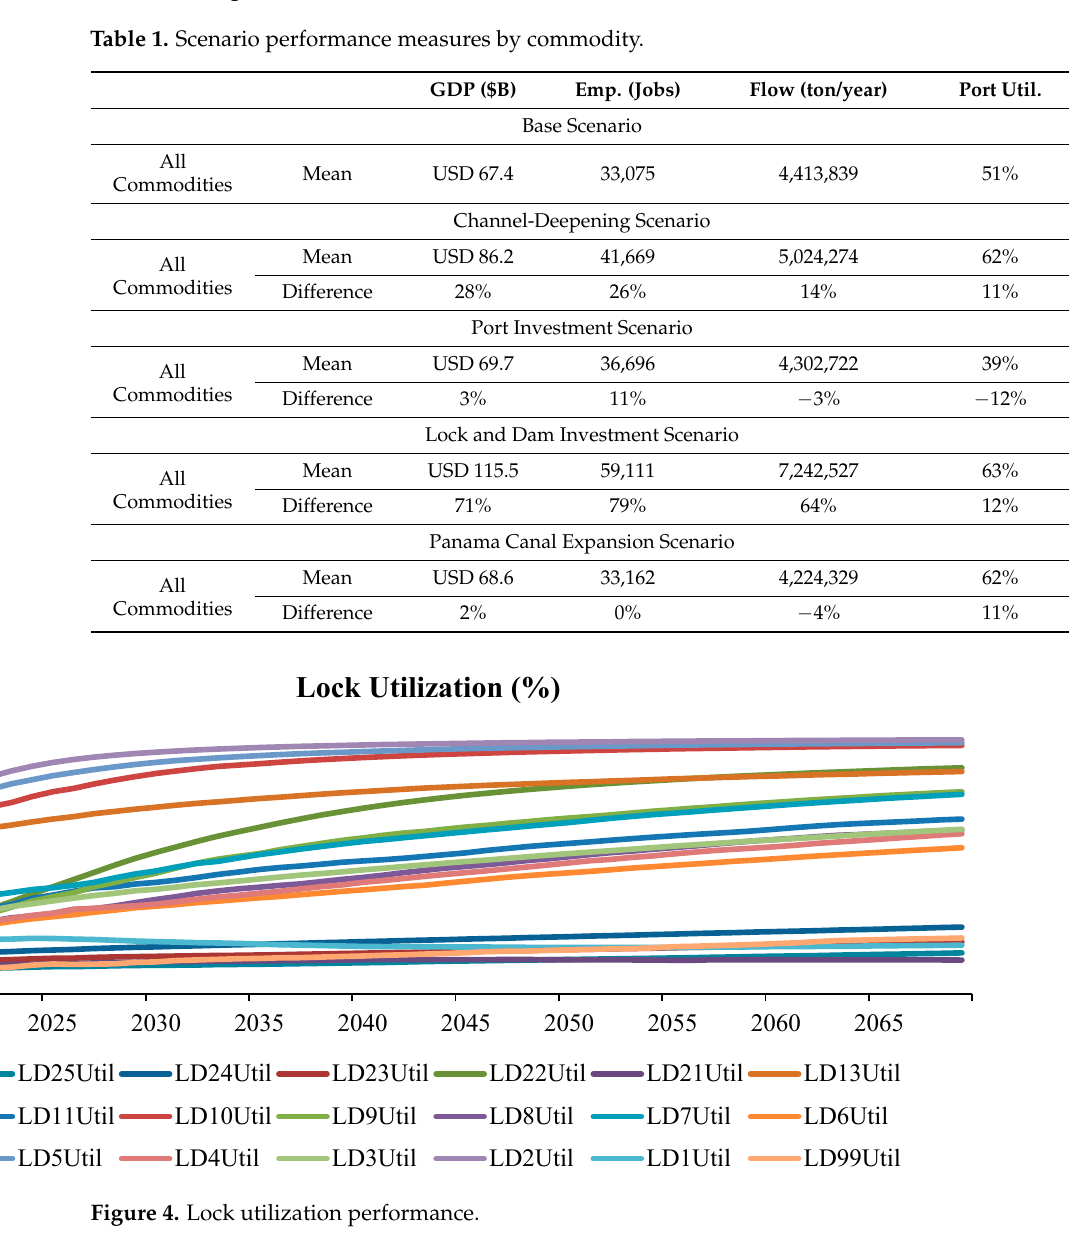
Figure 4. Lock utilization performance.